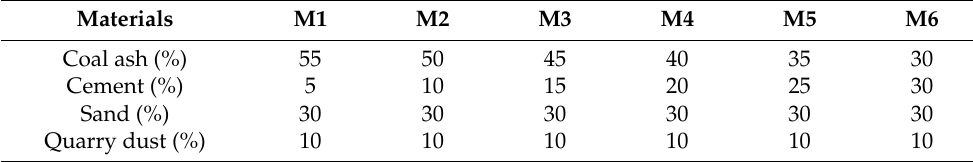
Table 2. Mixtures for the development of